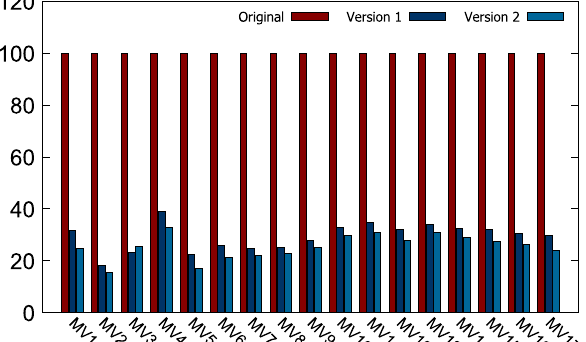
Fig. 7 Movie summarization